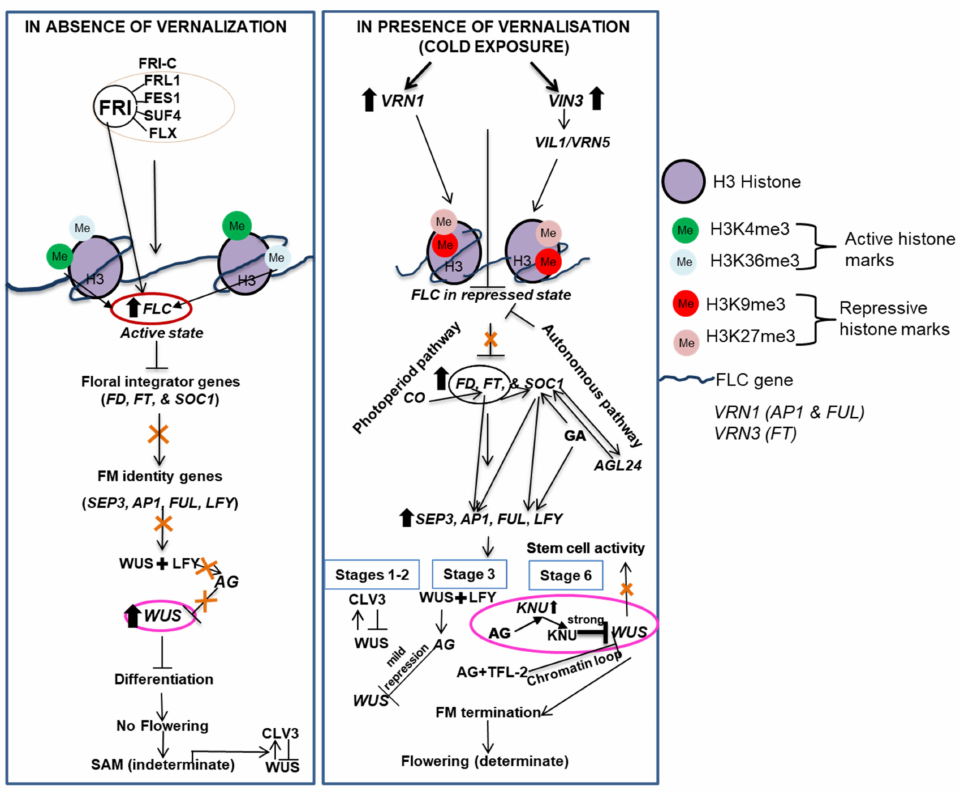
Figure 4. Simple heuristic model of the FRI-mediated FLC activation and vernalization-induced flowering pathway of Arabidopsis . In the absence of vernalization, FLC remains activated by a scaffold protein known as FRI. Because of the allelic variation in FLC and FRI , there is existence of natural variation in the requirement of vernalization. It must be noted that not all plants required to exhibit above mentioned model. AG, AGAMOUS; AGL24, AGAMOUS-LIKE 24; APETALA 1 (AP1);